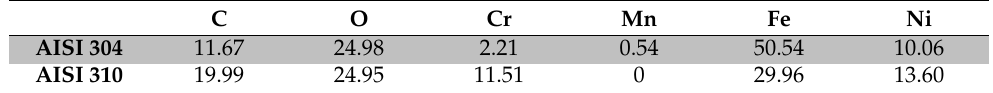
Table 3. Atomic weight of